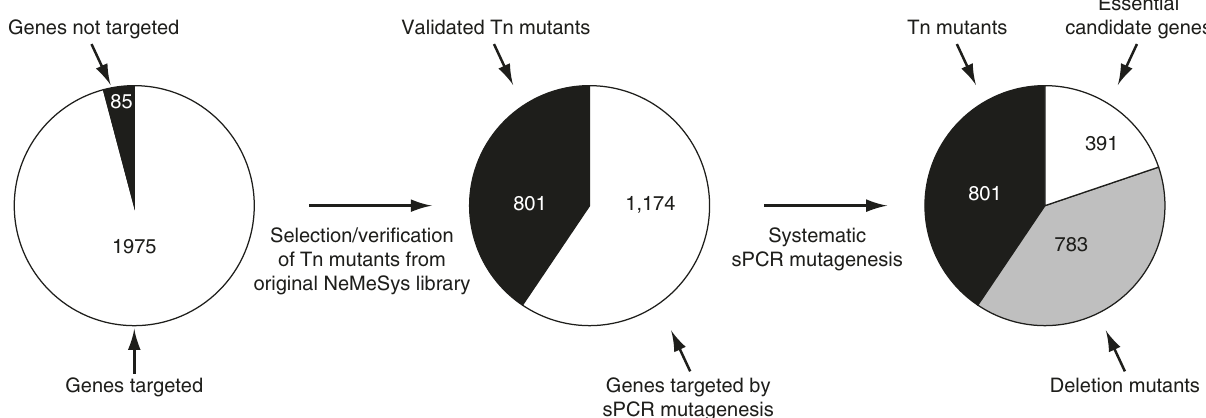
Fig. 1 Flowchart of the construction of the NeMeSys 2.0 complete collection of mutants in N. meningitidis 8013. As for similar efforts in other bacteria 10,12,13 , we fi rst selected protein-coding genes to be targeted by systematic mutagenesis, excluding 85 genes (4.1%, highlighted in black in the fi rst pie chart) because they encode transposases of repeated insertion sequences, or correspond to short remnants of truncated genes or cassettes (Supplementary Data 1). We then followed a two-step mutagenesis approach explained in the text and in Supplementary Fig. 1. In brief, we fi rst selected a subset of sequence-veri fi ed Tn mutants from a previously constructed arrayed library 16,17 . Mutations were re-transformed in strain 8013 and PCR-veri fi ed. We thus selected 801 Tn mutants with a disrupting transposon in the corresponding target genes (highlighted in black in the second and third pie charts). Next, we systematically mutagenised the remaining 1174 target genes using a validated no-cloning mutagenesis method relying on sPCR 20 . For each successful transformation, two colonies were isolated and PCR-veri fi ed. To minimise false-positive identi fi cation of essential genes, each transformation that yielded no transformants was repeated at least three times. In total, we could construct an additional 783 mutants (highlighted in grey in the third pie chart), generating an ordered library of de fi ned mutants in 1584 meningococcal genes (Supplementary Data 3). This effort also identi fi ed 391 candidate essential genes, which could not be disrupted, encoding proteins required for N. meningitidis growth on rich medium (Supplementary Data